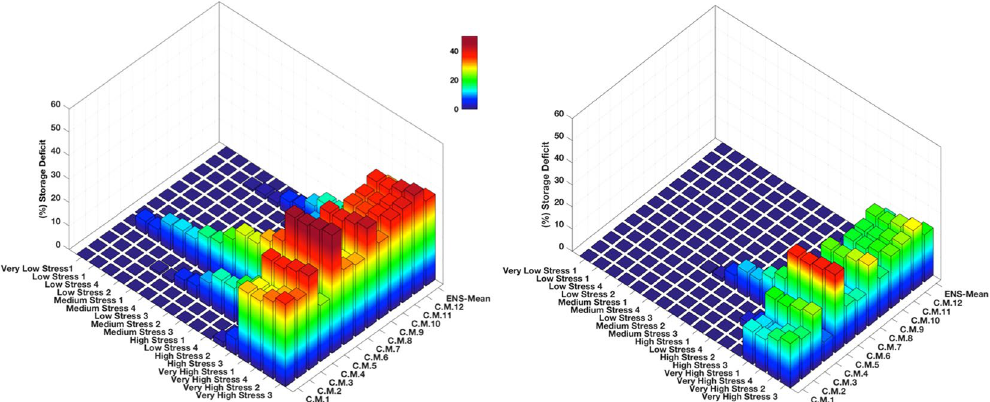
Figure 4. ( a ) Melbourne’s average water storage deficit based on different climate model simulations (C.M.1– 12–Table S1) and their ensemble mean (ENS-Mean) under different future demand scenarios (Table S2) in 2020–2035 relative to the baseline (1995–2010). ( b ) Same as ( a ) but considering alternative water sources with the annual capacity of 150